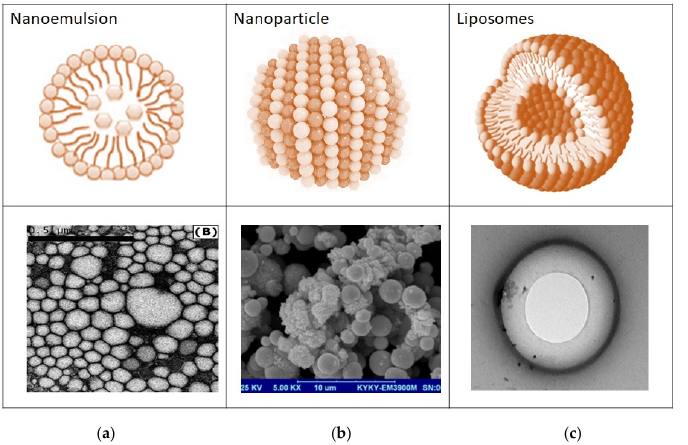
Figure 6. Electron microscopy analysis of ( a ) nano emulsion (reprinted from ref. [93] with permis- sion from Elsevier, 2012), ( b ) nanoparticle [94], and ( c ) liposomes [95].